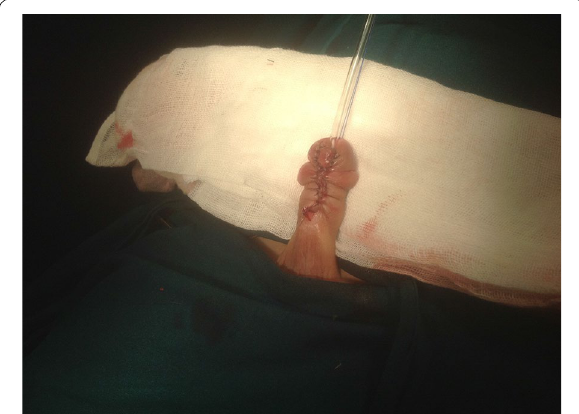
Fig. 4 Covering the urethral plate with the first part of the flap